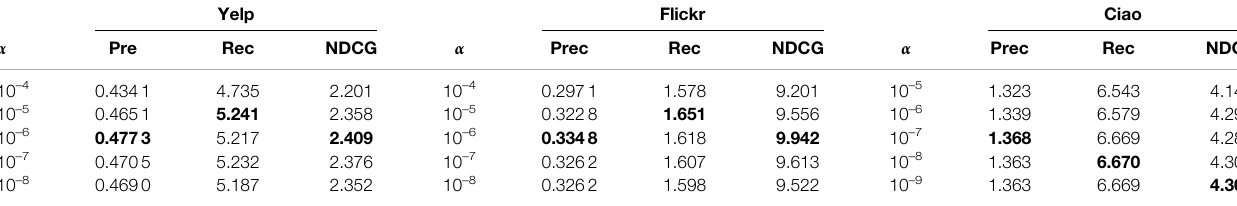
TABLE 9 | Performance of CGL with respect to different values of α ( K = 20). The best results are in bold. Yelp Flickr Ciao α